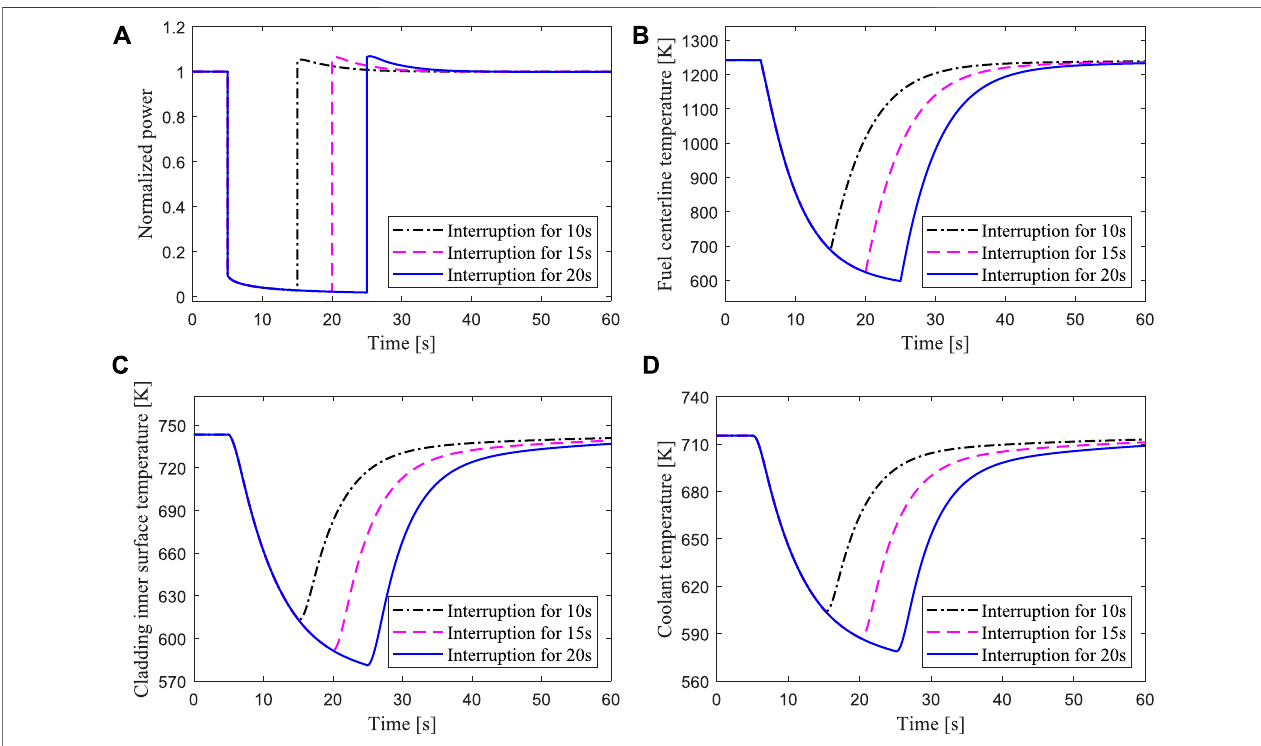
FIGURE 8 | Transient responses of the hottest channel under beam interruptions for 10 s, 15 s, 20 s respectively.